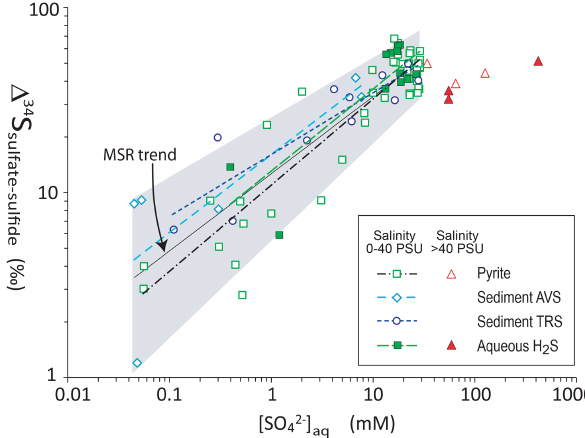
Figure A3. Replotted MSR-trend data (from Fig. 2, Table S1) as a function of sulfide δ 34 S source (symbols as given in legend). Sep- arate regressions for the four different sulfide phases (dashed lines; calculated for 0–40PSU only) show small differences in slopes and y intercepts (Table A1), although the regression lines are statisti- cally ] SW 4